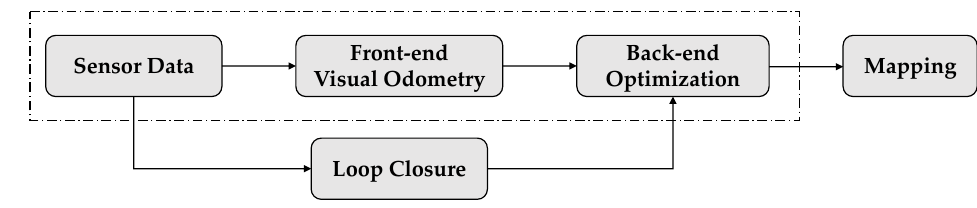
Figure 1. Process Diagram of SLAM.